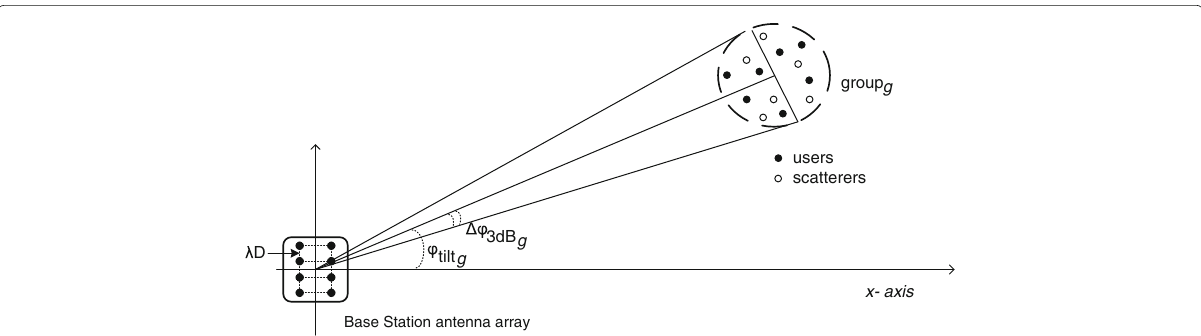
Fig. 7 Geometrical one-ring model extended to a group. This figure represents the correlation between the VSC and the one-ring model for correlation